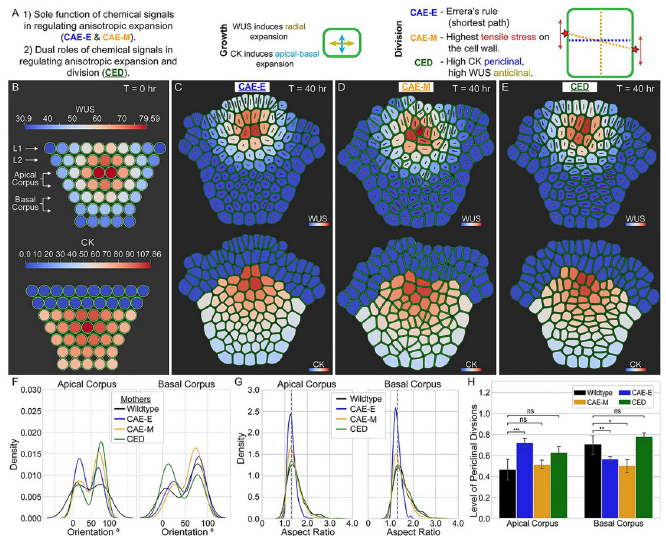
Fig 5. Results of computationally testing three hypothesized mechanisms of cell division plane orientation in the corpus. (A) Three hypothesized mechanisms for WUS and CK-mediated regulation of cell division plane orientation and the direction of anisotropic expansion of cells. (B) Cells are initialized as circles and allowed to “relax” into more biological cell shapes before growth and division begin (see S3 Appendix for details on model initial and boundary conditions). The internal colors of cells represent their levels of WUS (top row) and CK (bottom row). (C-E) Final simulation time point after 40 hours of growth reveals differences in cell shapes and orientations between each of the three mechanisms. The internal color shows the final levels and spatial patterns of WUS (top row) and CK (bottom row). Line segments inside cells are provided to help visualize cell aspect ratios and orientations. The length of each line segment is proportional to the encompassing cell’s aspect ratio, where cells with aspect ratio = 1 have line segments with length 0. The directional vector of each line segment represents the orientation of the longest axis of the encompassing cell. Purple lines denote daughter cells while yellow lines denote mother cells (see S1 Appendix for details on mother/daughter cell classification). (F) The distributions of mother cell orientations for the CAE-E (blue), CAE-M (gold), and CED (green) mechanisms were not statistically different from wildtype experiments (black) in both the Apical corpus (p-value = .5520, .6841, and.8330 respectively) and Basal corpus (p-value = .7567, .3103, and .2173 respectively). (G) The distributions of cell aspect ratios for the CAE-M (gold) and CED (green) mechanisms were not statistically different from wildtype experiments (black) in both the Apical corpus (p-value = .4879 and .9521 respectively) and Basal corpus (p-value = .1724 and .5781 respectively) while the CAE-E mechanism was significantly different (p-values < 1.0e-32 in both cell layers). (H) Proportion of periclinal cell divisions in the Apical and Basal corpus for all three mechanisms. In the Apical corpus, the CAE-M and CED mechanisms matched experiments, while the CAE-E mechanism did not (p-value = 2.93e-4). In the Basal corpus, only the CED mechanism matched experiments (p-value = 5.5e-3 and 3.86e-2 for the CAE-E and CAE-M mechanisms respectively). S2 Fig provides extended analysis between experimental wildtype SAMs and wildtype simulations for all four hypothesized mechanisms presented in this